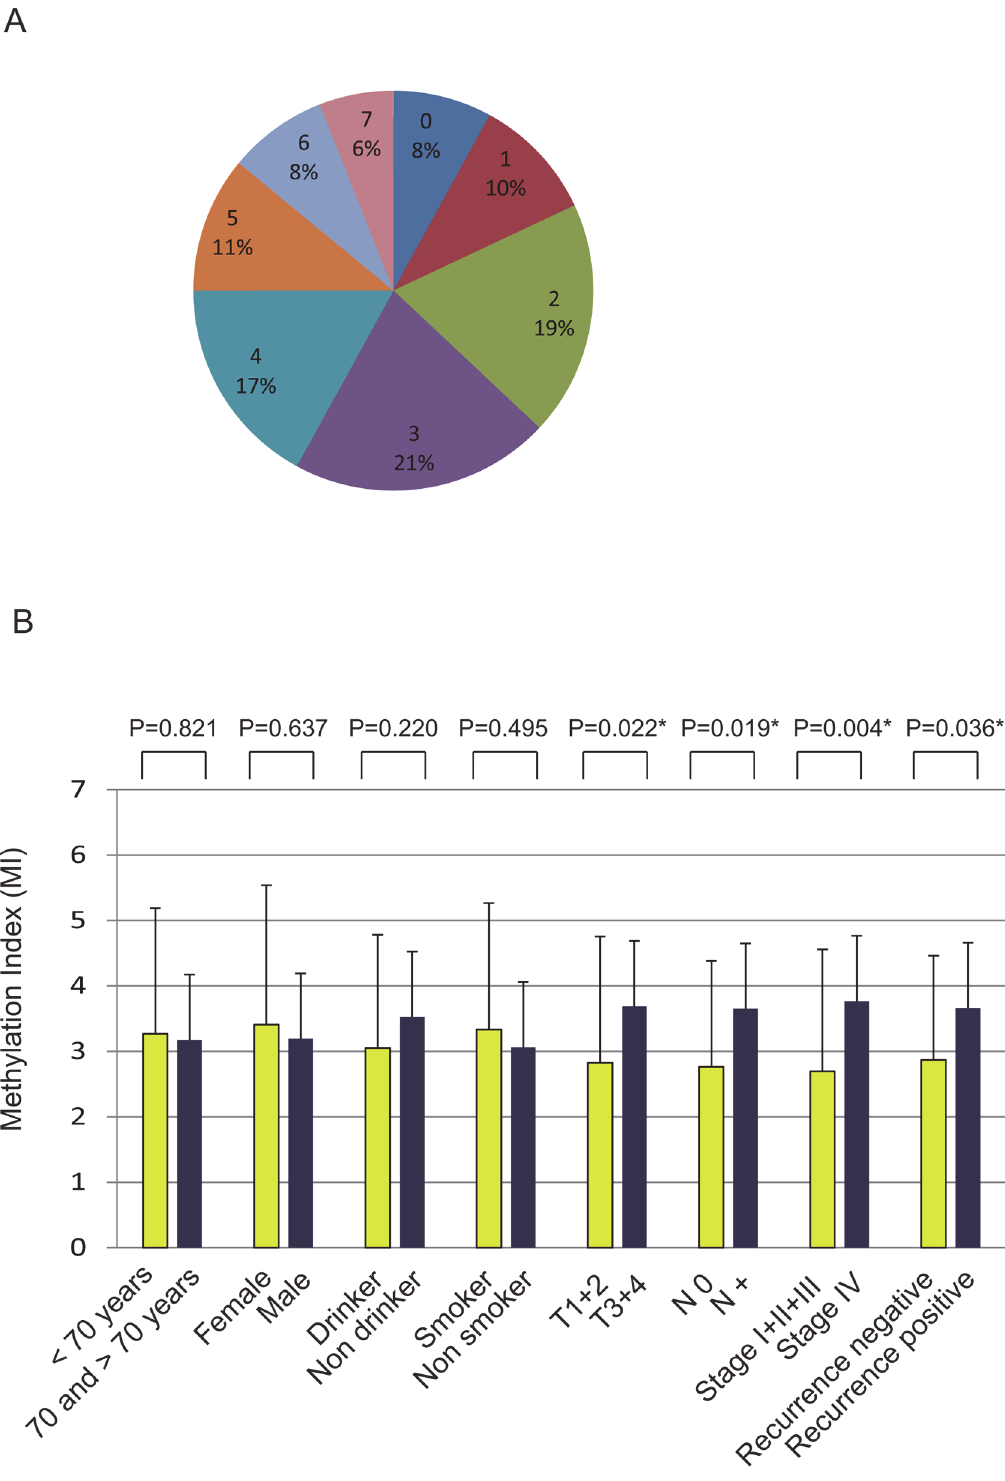
Fig 3. Gene promoter methylation analysis by quantitative-MSP in 100 primary HNSCC samples. (A) Percentage of patients with epigenetic alternation in SST , SSTR1 , TAC1 , TACR1 , galanin , GALR1 , and GALR2 genes. (B) Comparison of MI among selected epidemiologic and clinical characteristics.